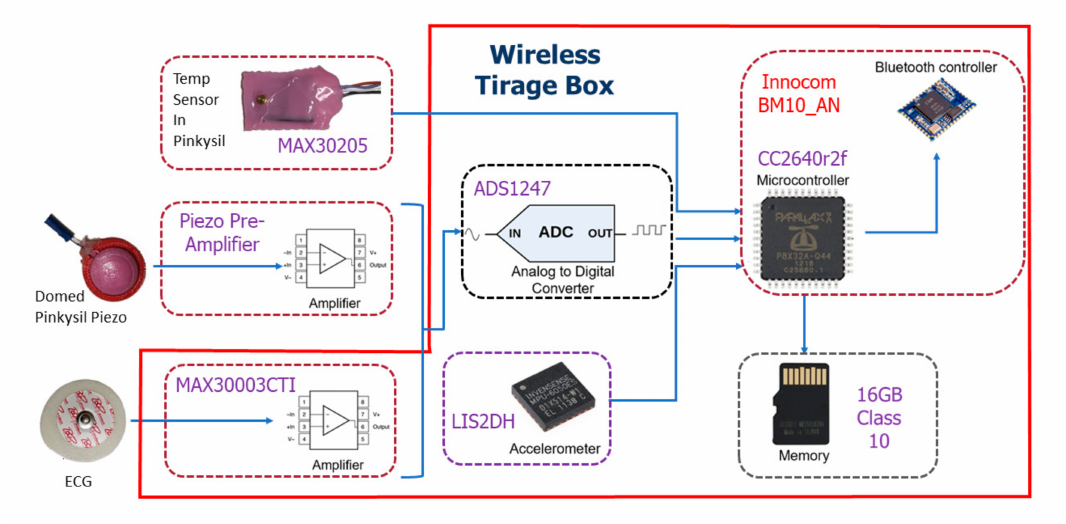
Figure 4. Proposed wireless triage device box with sensor frontends depicting the system architecture of data flow.